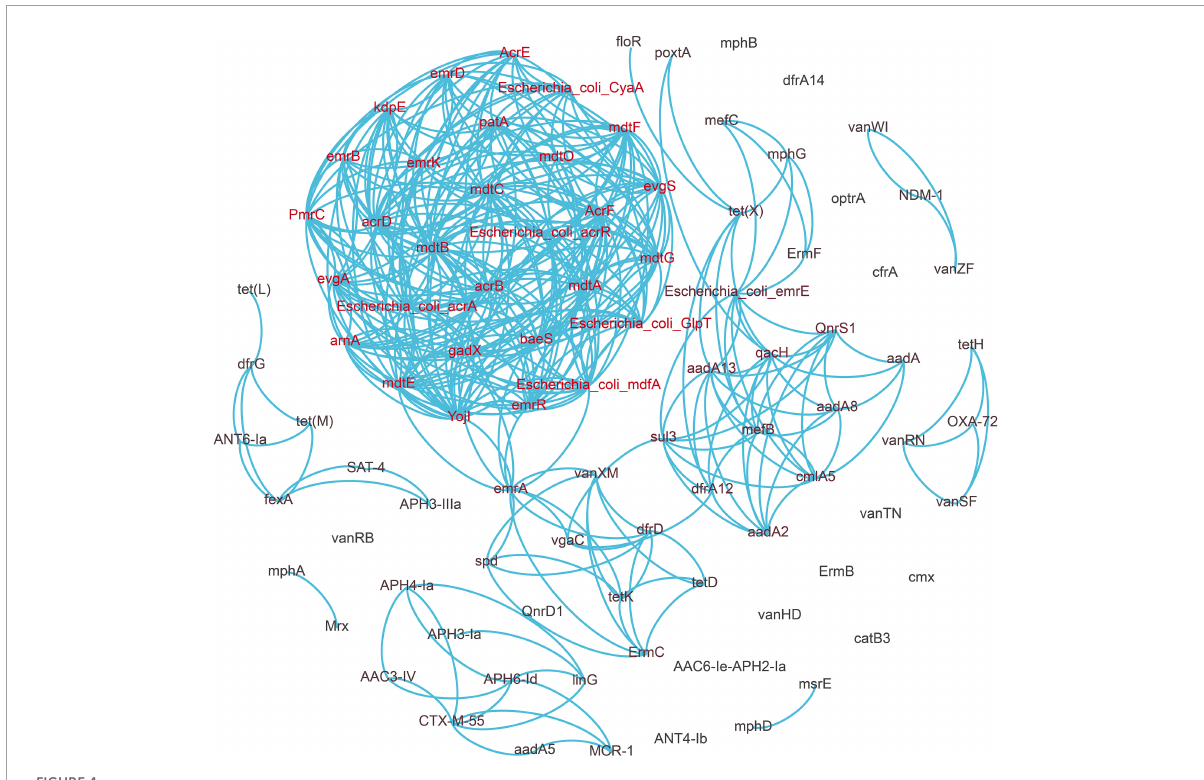
FIGURE4 Network analysis revealing the co-occurrence patterns between antibiotic resistance genes (ARGs). A connection represents a strong relationship between ARGs (Pearson’s correlation coefficient r ≥ 0.9, p <